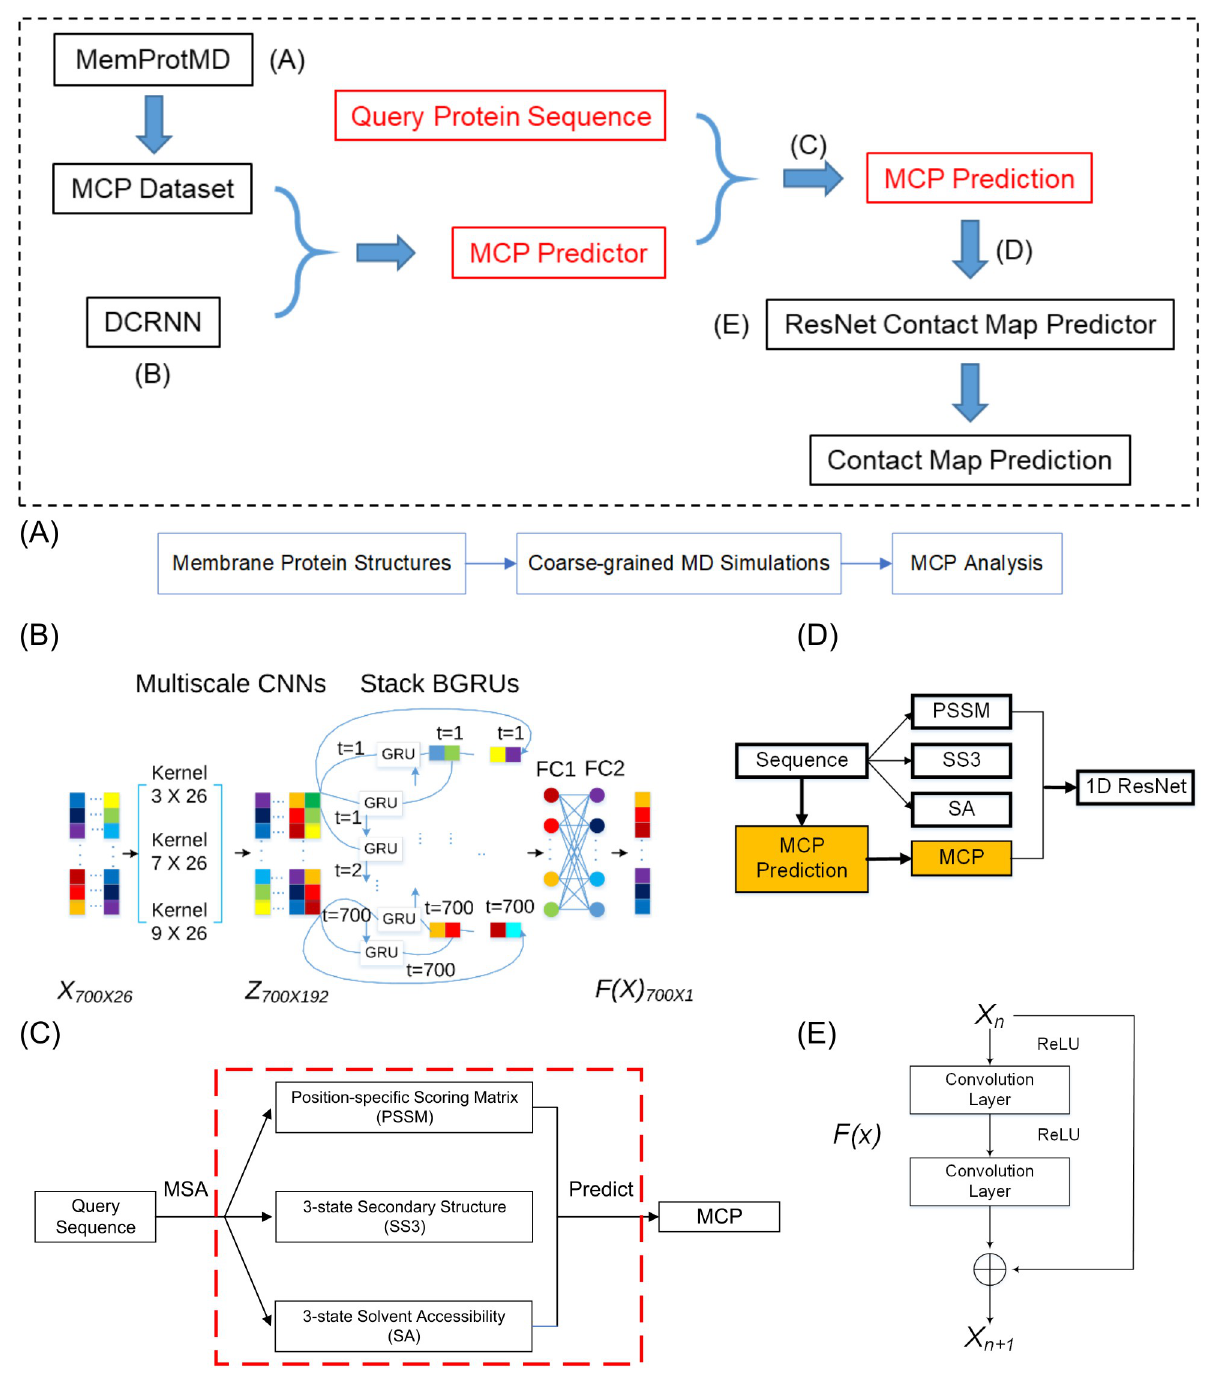
Fig 1. The method schemes. The overall scheme is presented in the black dashed rectangular in the top panel, and the key steps are described in: (A) Extraction of MCP from the MemProtMD database. (B) The DCRNN model for the MCP prediction. (C) The process of MCP prediction from a query sequence. (D) The method of MCP incorporated into the ResNet model. The MCP was used as a 1D input in the same way as SA. (E) The unit of the ResNet model. Each unit of the ResNet model contains two convolution layers and two activation layers.